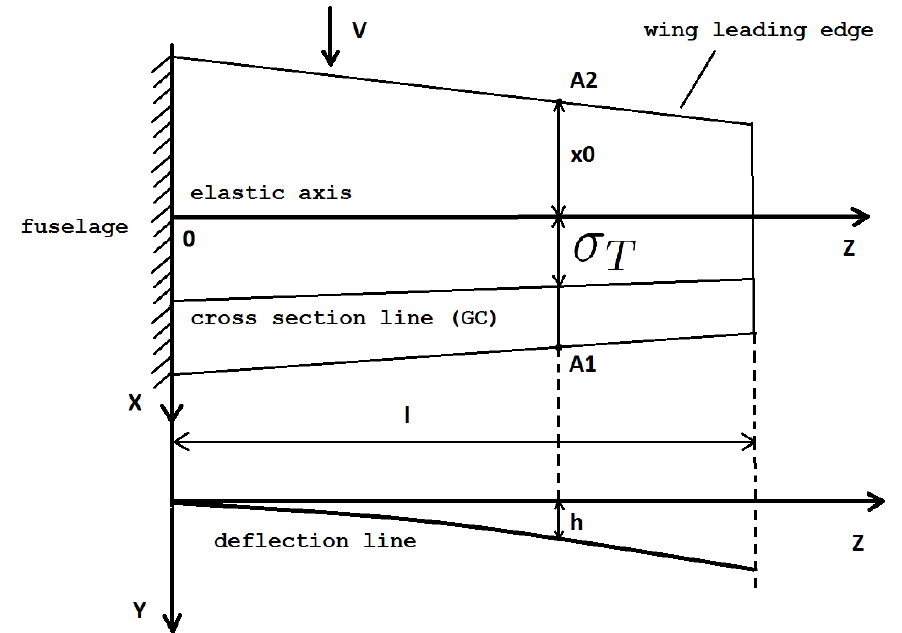
Figure 2. Stiffness Centers and Gravity Centers lines on a wing, where O − Z is the elastic axis containing the stiffness centers of the wing section; X -axis is codirectional with steady airflow V; Z -axis is directed along the elastic axis of the undeformed wing; Y -axis complements the coordinate system in the vertical direction; x 0 is the distance from the leading edge of the wing to the SC section; σ T is the distance between SC and GC; h is the transverse deflection of the section A 1 A 2 ; l is the half-span of the